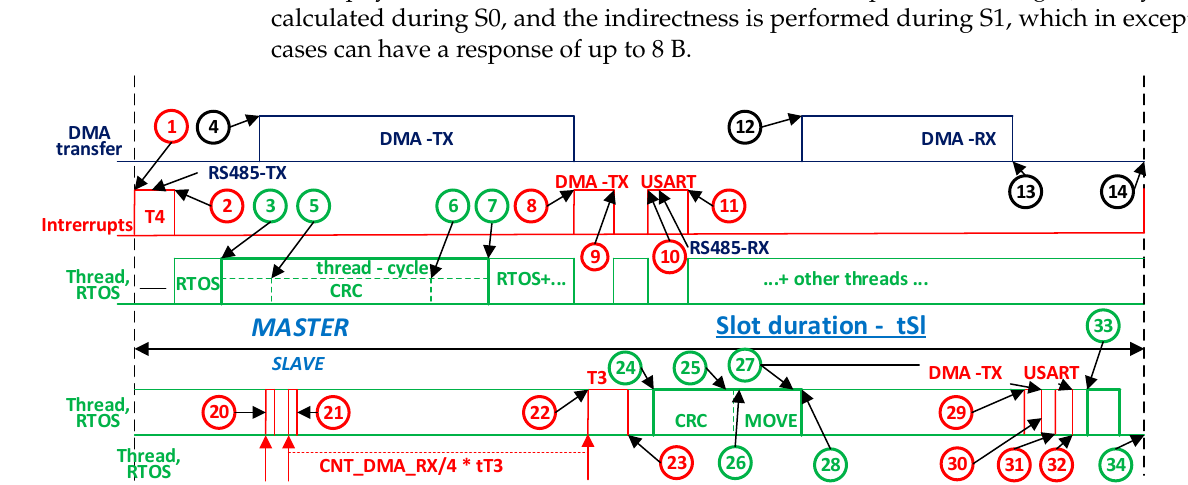
Figure 9. Time structure of a slot in the AC implemented with µ C STM32F407 (168 MHz) for both client (MASTER) and server (SLAVE) (important and predictable periods).